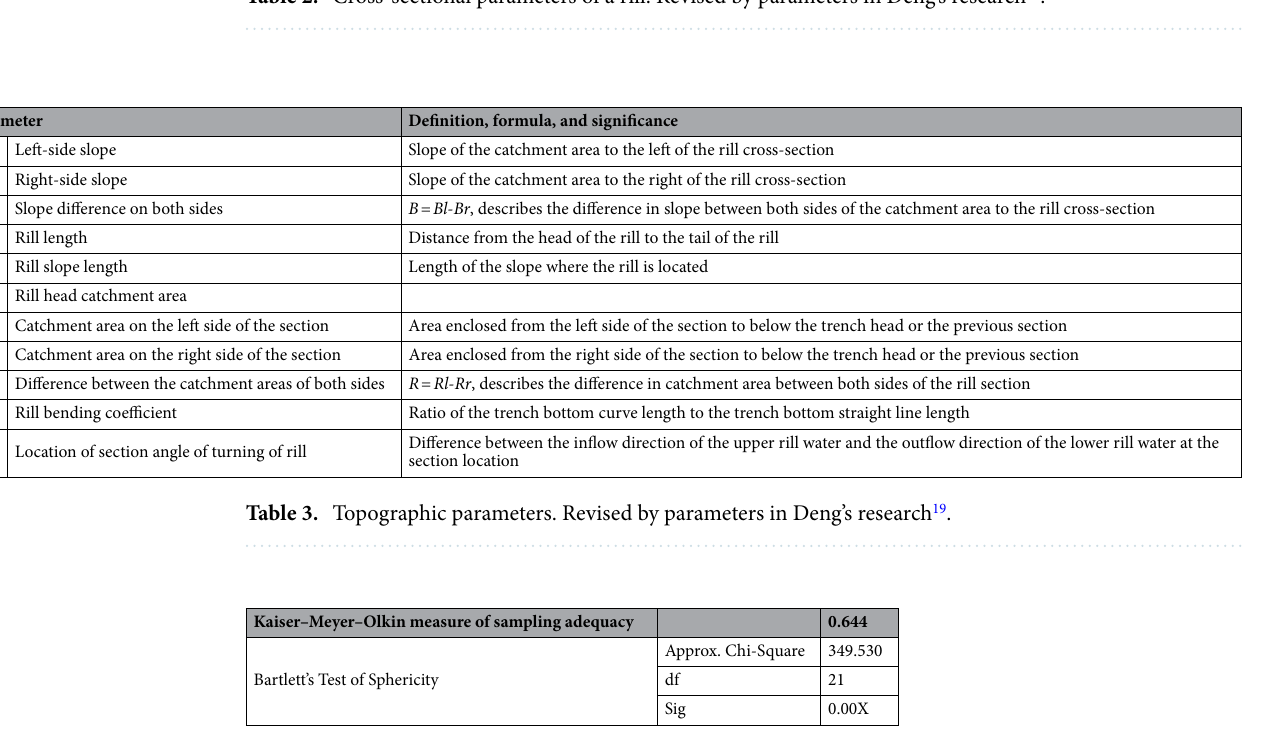
Table 2. Cross-sectional parameters of a rill. Revised by parameters in Deng’s research 19 .